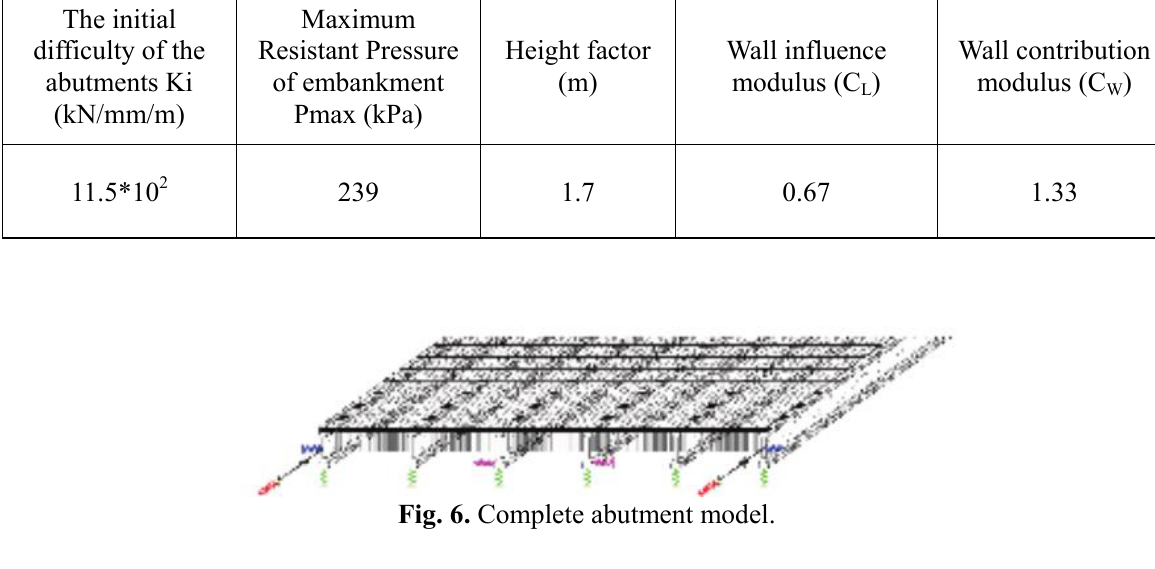
Characteristics used to model abutments in longitudinal and horizontal directions. The initial